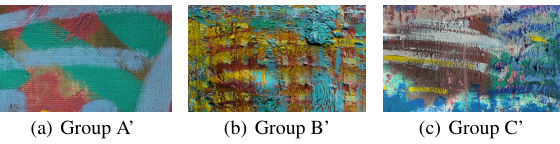
Figure 8. Cropped parts of RTI data from Figure 7 of each